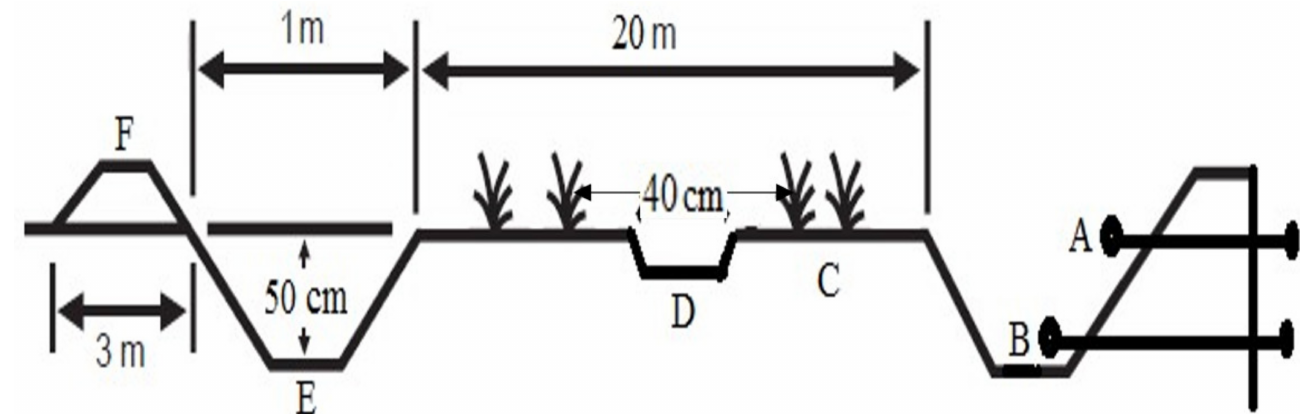
Figure 1. Construction of the Minapadi pond (cross section) description: ( A ) water inlet channel, ( B ) lower water outlet channel, ( C ) rice plot, ( D ) middle ditches, ( E ) main ditches, and ( F )